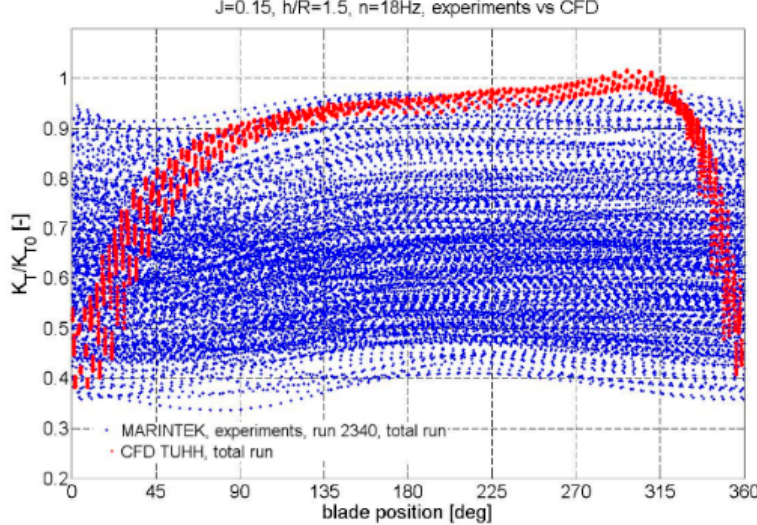
Figure 11. Thrust loss factor as a function of blade position, red markers correspond to CFD calculations, and blue markers correspond to experimental results ( Koz10 ).